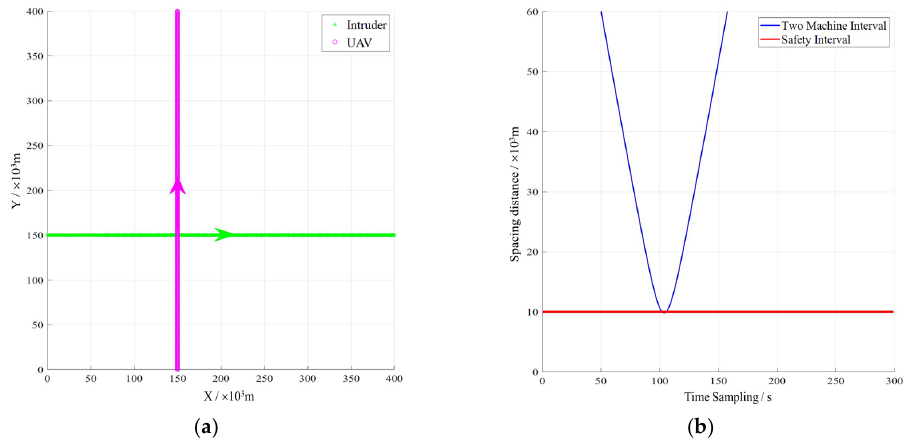
Figure 9. Speed deliverance scenario analysis: ( a ) speed relief scenes; ( b ) two-machine interval.